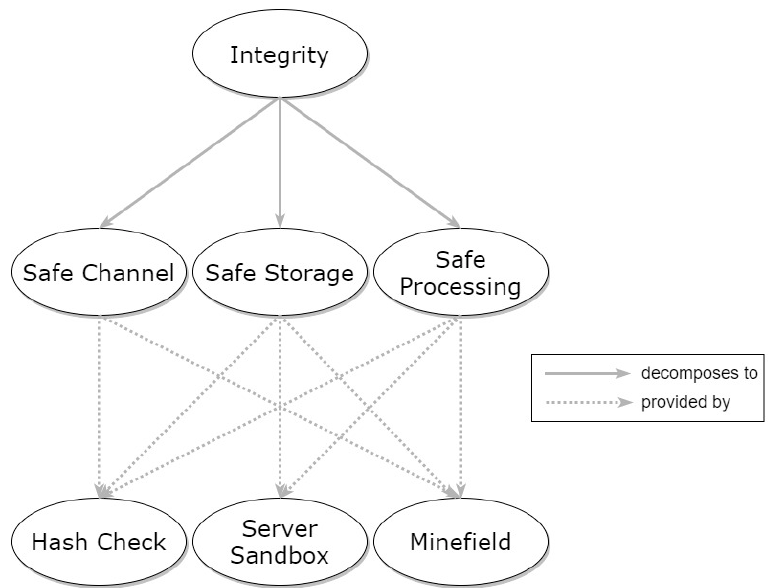
Figure 6. Hierarchical graph of Integrity property and relevant